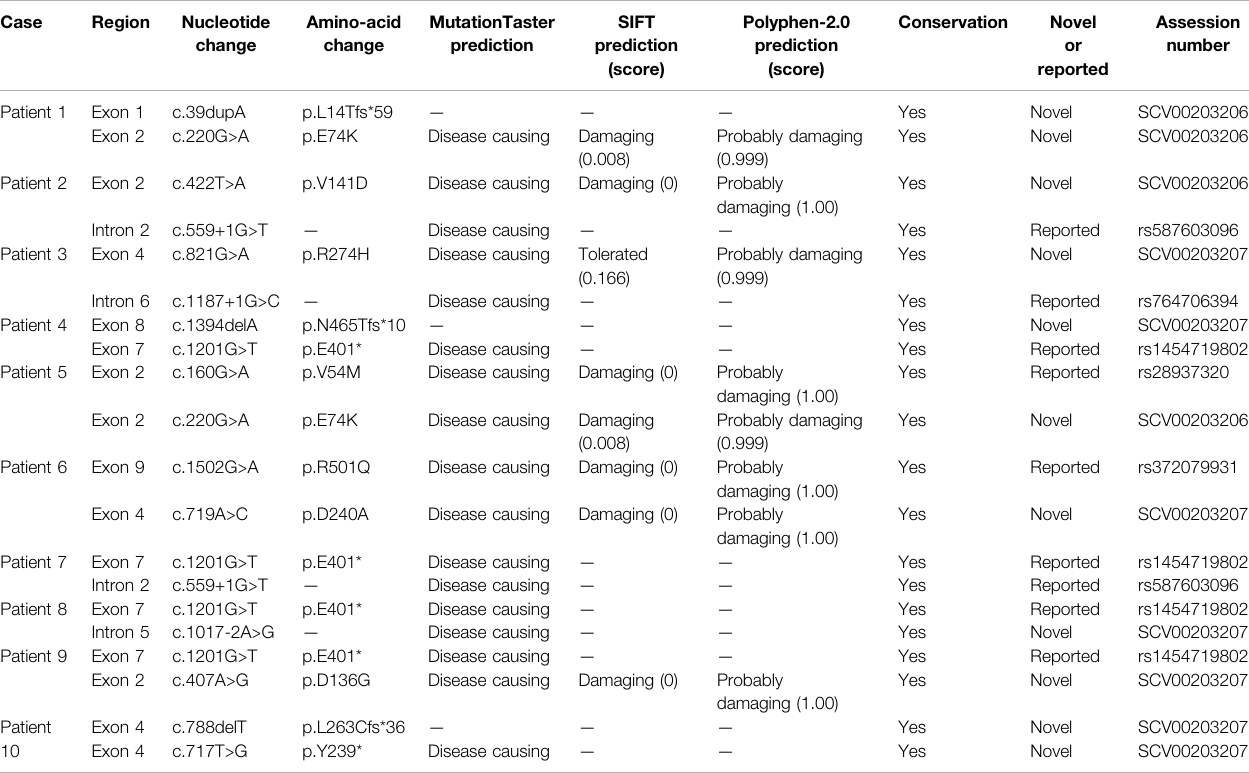
TABLE 2 | Molecular analysis of HMGCS2 gene identi fi ed in 10 new Chinese patients with HMGCS2D. Case Region